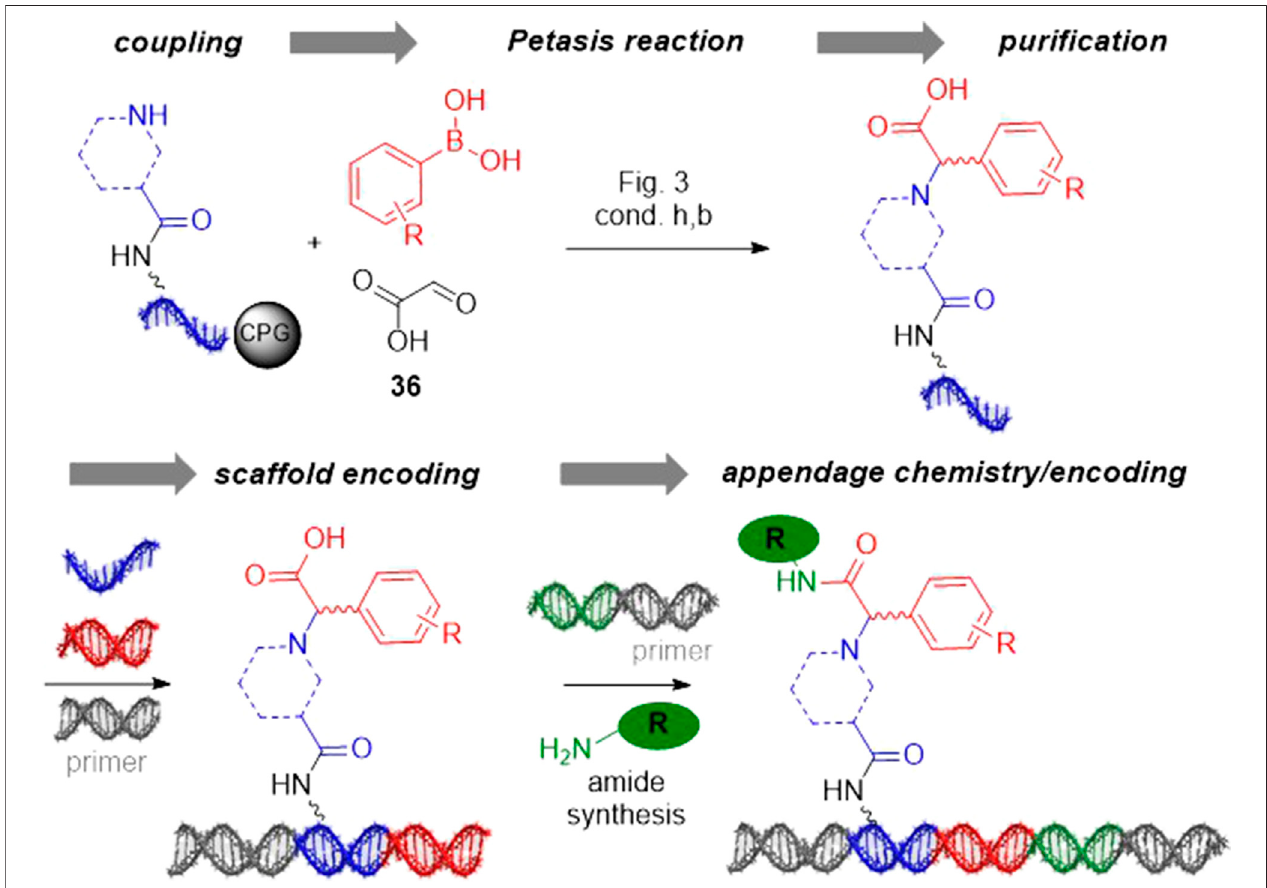
FIGURE 4 | Exemplary DNA-encoded library design based on the Petasis reaction. DEL synthesis is initiated with coupling of secondary amines to the stabilized barcode. Petasis reaction on encoded amines gives for instance diverse N-substituted arylglycines. These are puri fi ed, encoded and substituted by amide bond formation in the third reaction step giving a library of diverse N-substituted arylglycine